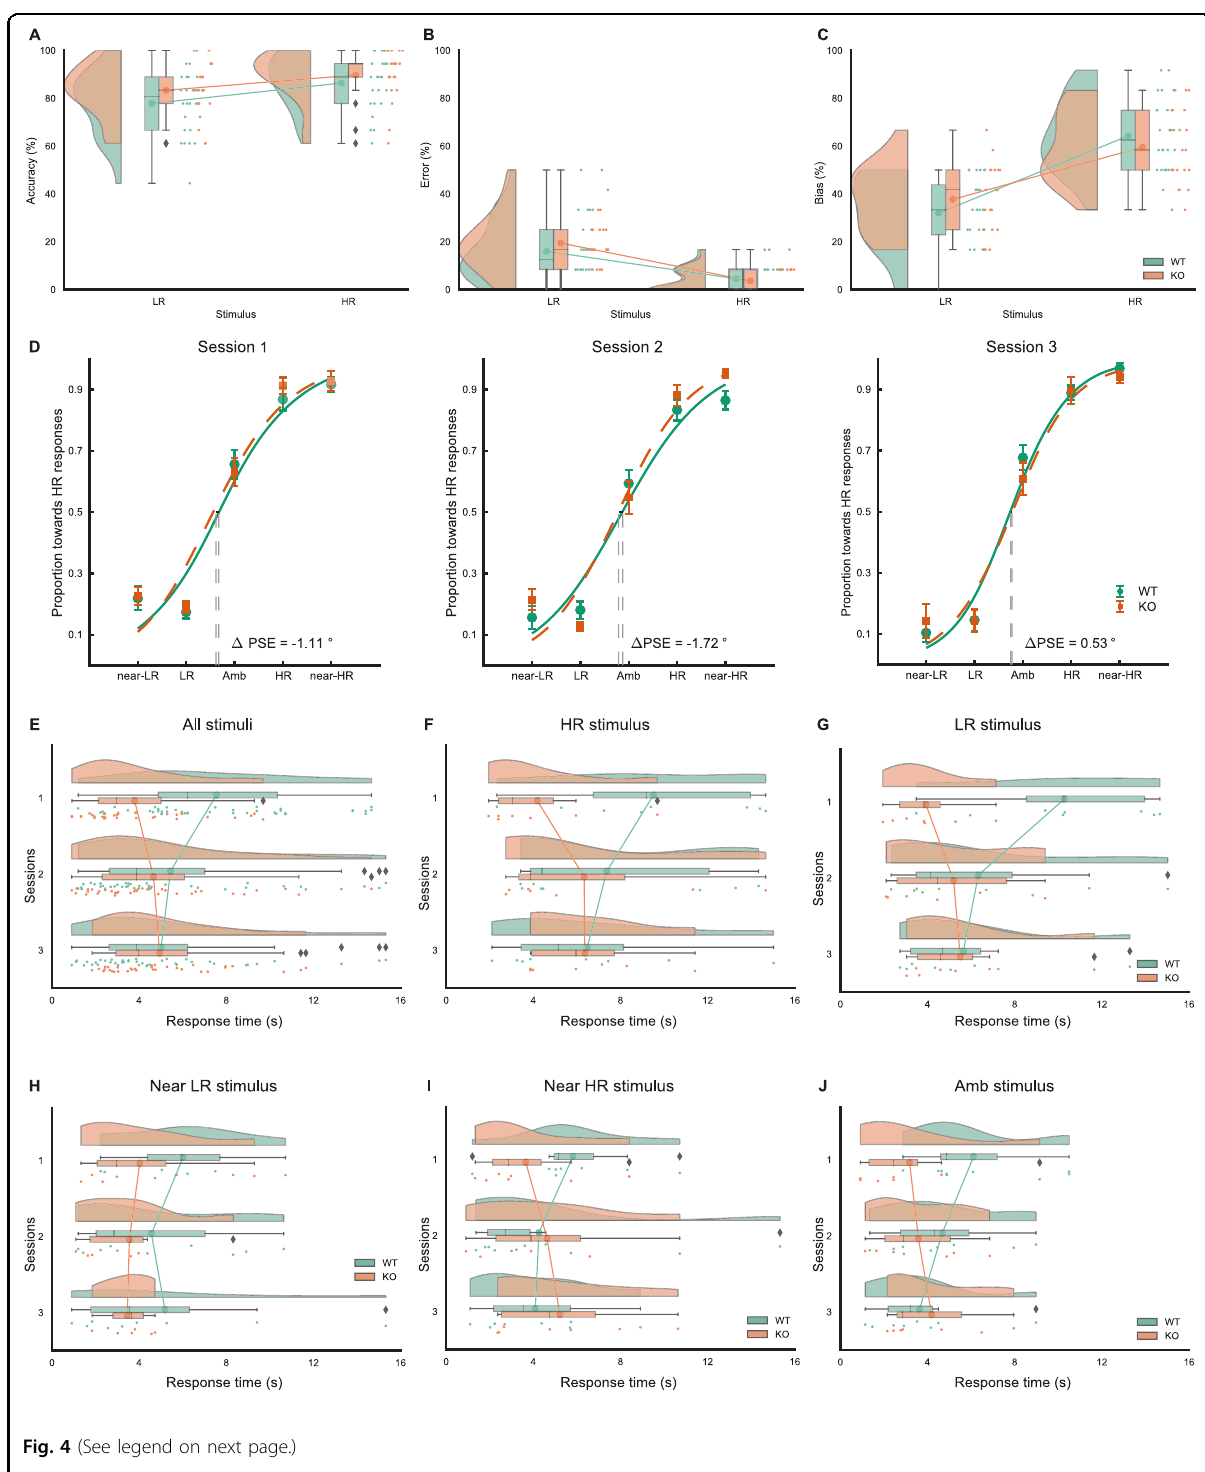
Fig. 4 (See legend on next